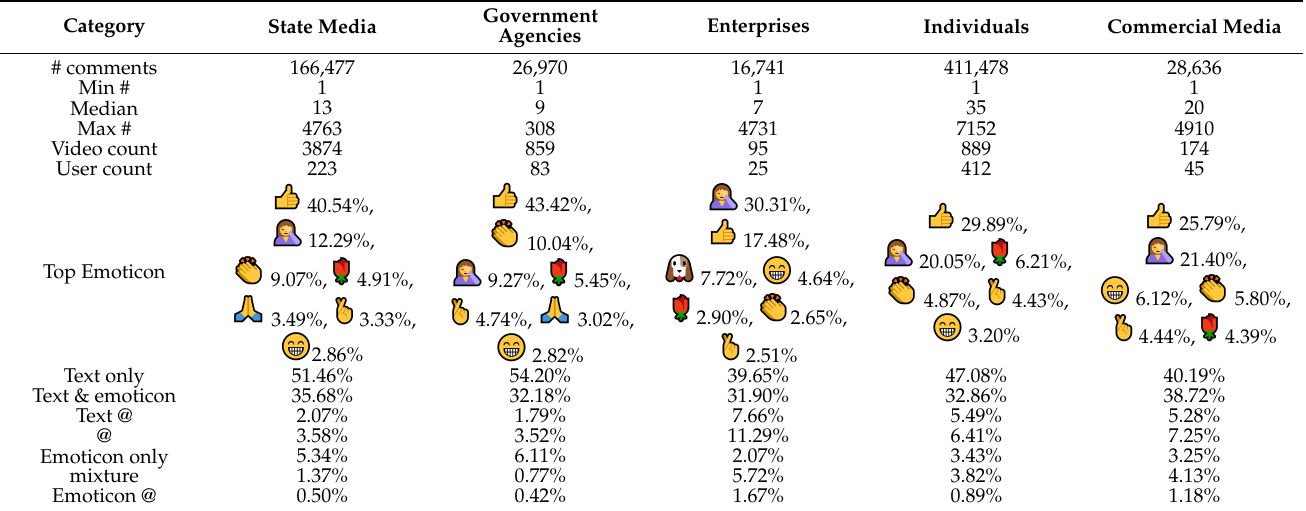
Table 3. Descriptive statistics of comments to videos by video ‐ producer type.